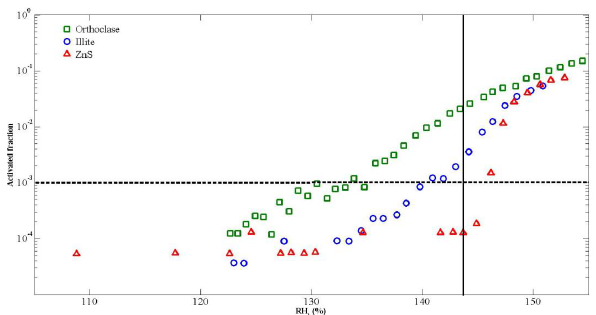
Fig. 2. Activated fraction as a function of RH i for orthoclase (green square), illite (blue circle), and ZnS (red triangle). The dashed black line represents an activated fraction of 0.001 and the solid black line represents water saturation.